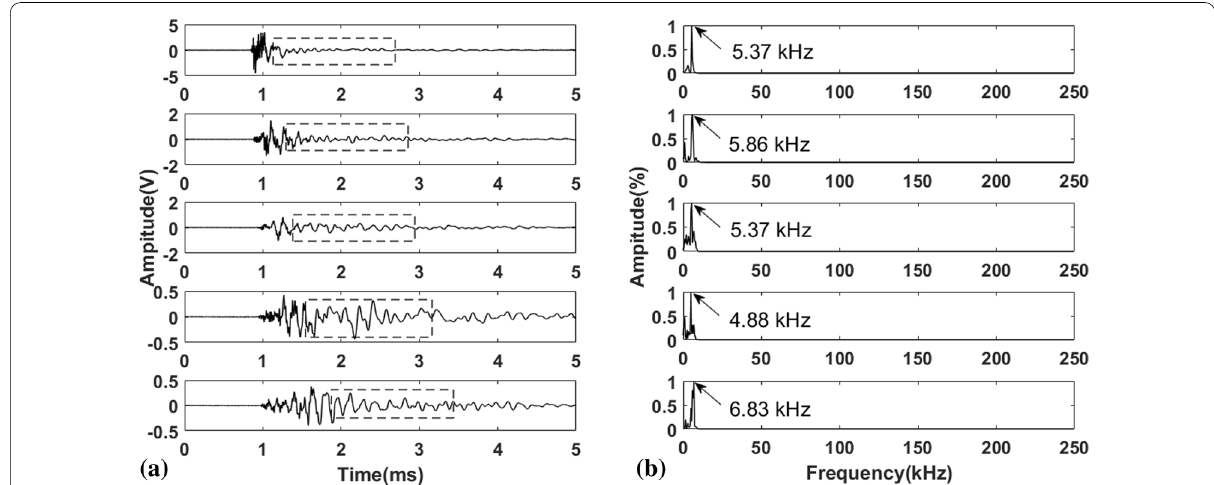
Fig. 3 AE waveform and standing wave frequency domain of PLB. a AE waveform produced by lead breaking. b Standing wave